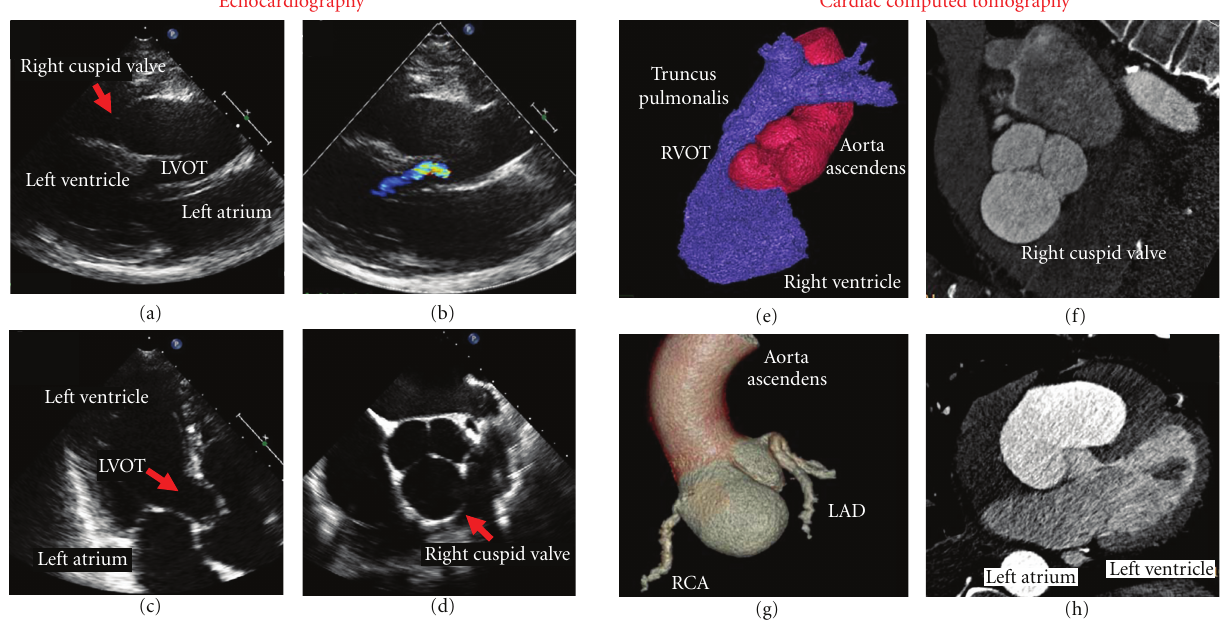
Figure 1: Comparison of transthoracic echocardiography and cardiac computed tomography angiography (CCTA). Short parasternal axis with and without aortic outflow tract (a) and (b), two-chamber view with left ventricular outflow tract (c), and top view with tricuspid aortic valve (d) and (f). Compression of the right ventricular outflow tract (e), 3D reconstruction of the aortic root (g), and four-chamber view (h) in CCTA. (LVOT: left ventricle outflow tract, RVOT: right ventricle outflow tract, LAD: left anterior descending, RCA: right coronary